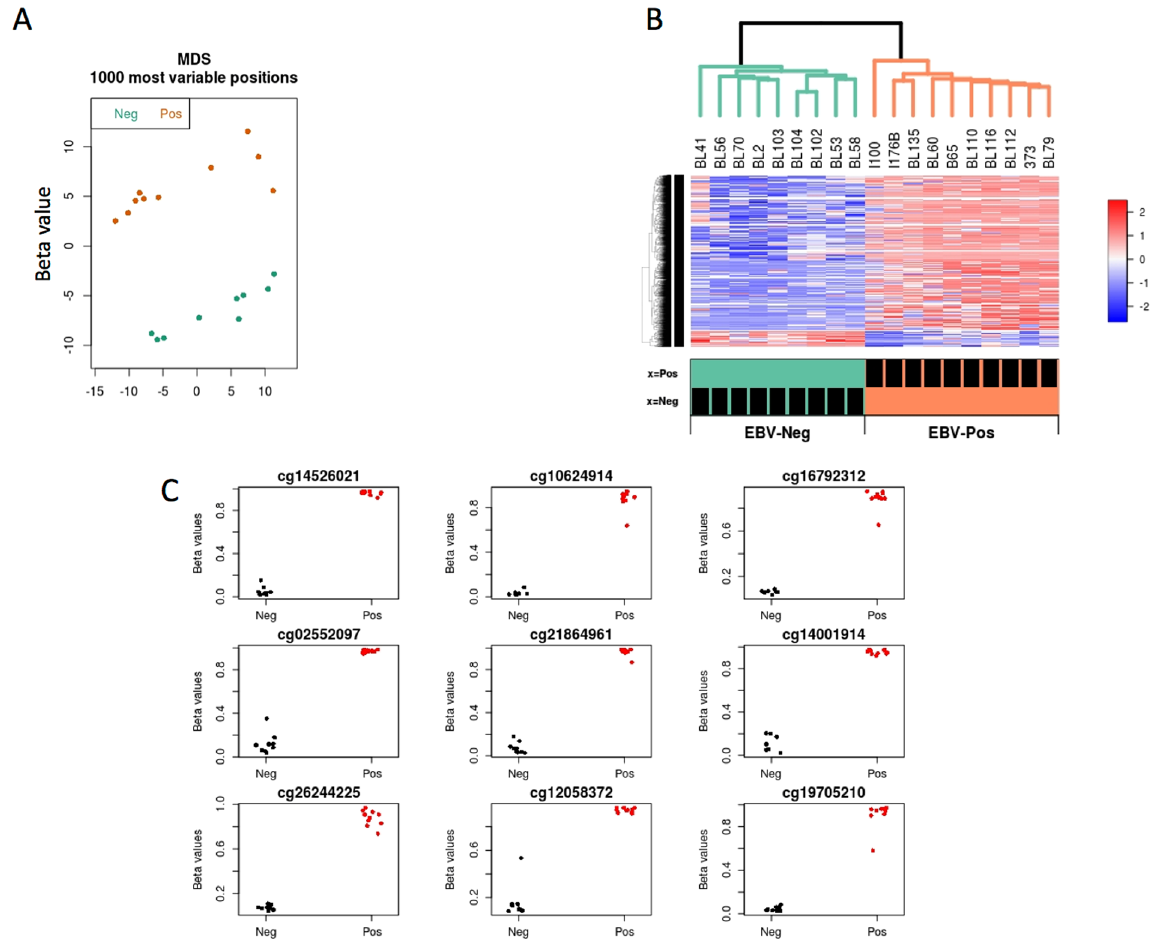
Figure 1. EBV-dependent methylation at the single CpG site level. BL samples were processed for genome- wide methylation analyses using HM450 bead arrays, as described in Methods. ( A ) Multi-dimensional scaling (MDS) plot showing two main groups of samples, generally matching EBV status. ( B ) Heat map of differentially methylated positions (DMPs) between the two EBV categories. ( C ) Example stripchart plots of the top most significant differentially methylated positions